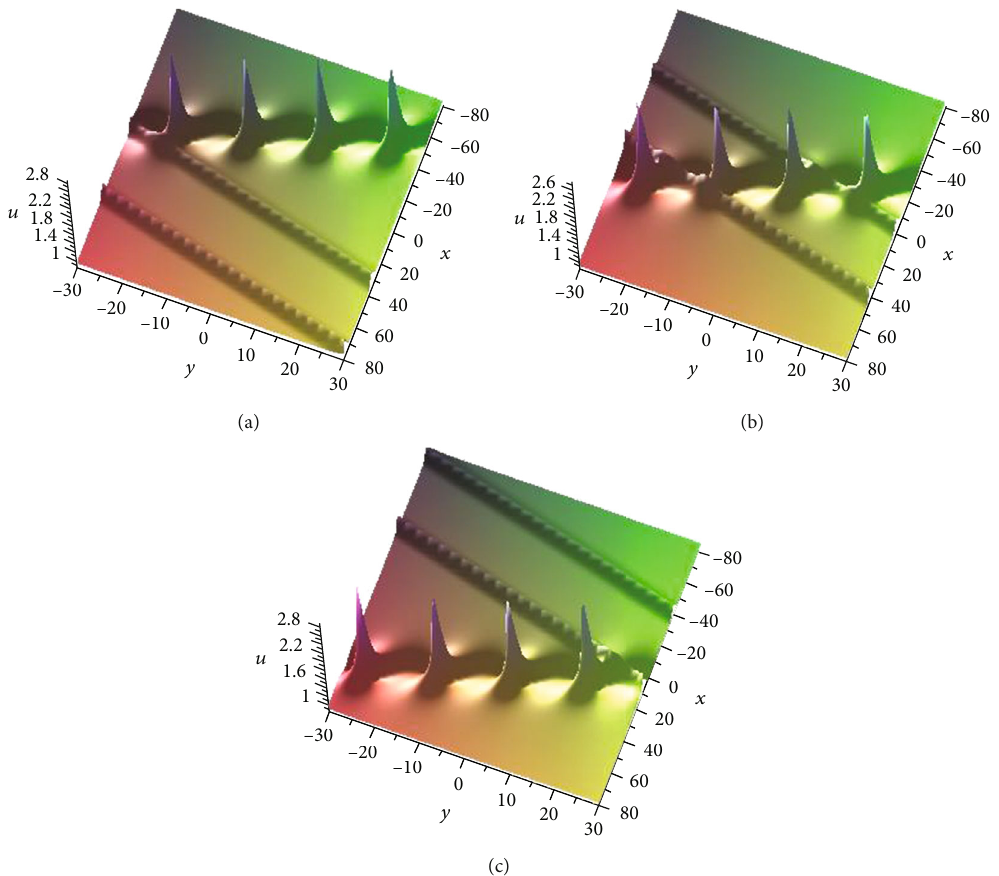
Figure 10: Propagation of hybrid solution composed of a soliton molecule and a breather at di ff erent times: (a) n = − 30 , (b) n = 0 , and (c) n = 30